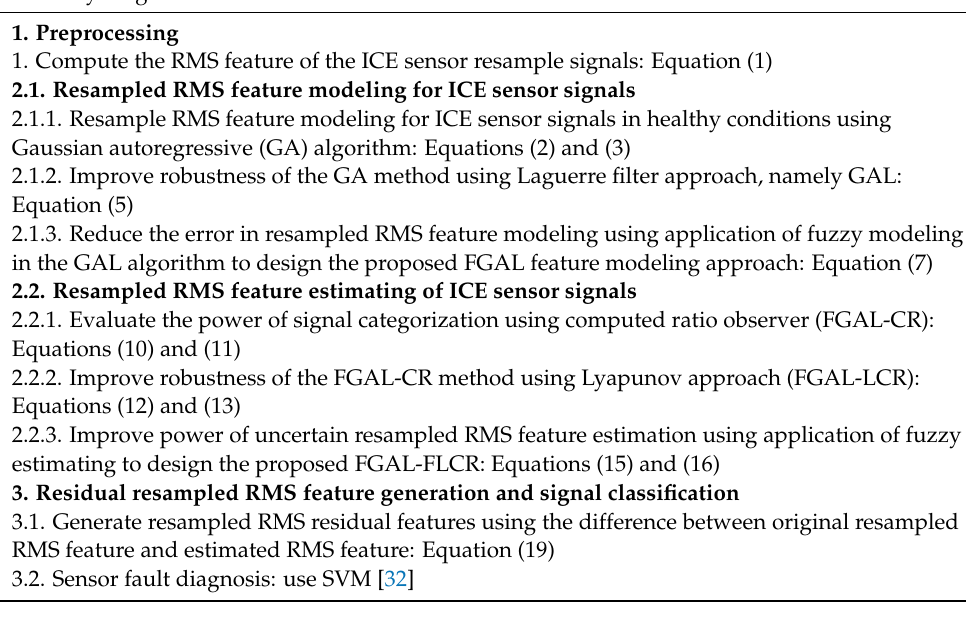
Algorithm 1: Proposed machine fuzzy Lyapunov-based computed ratio algorithm for ICE sensor anomaly